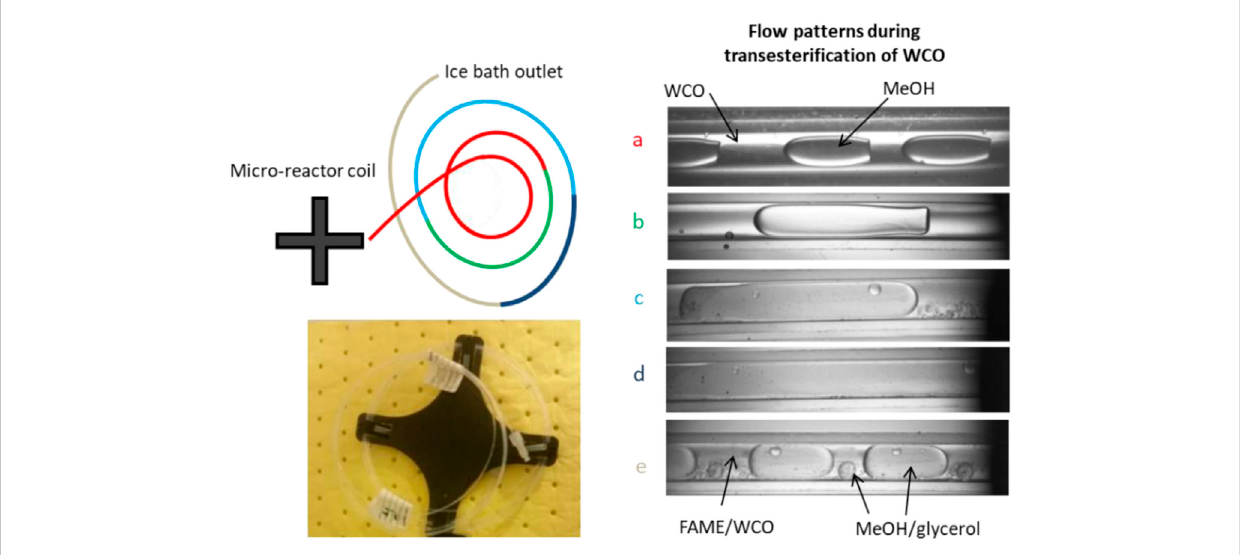
FIGURE 3 Flow pattern transition in a micro-reactor coil during transesteri fi cation of WCO to biodiesel. (Methanol-to-oil molar ratio, 12; Temperature, 60 ° C; catalyst concentration, 1.4 %w/w, residence time, 1 min; Q tot =60 cm 3 /h). (A – E) correspond to the fl ow pattern observed to each speci fi c section of the reactor indicated by colour.